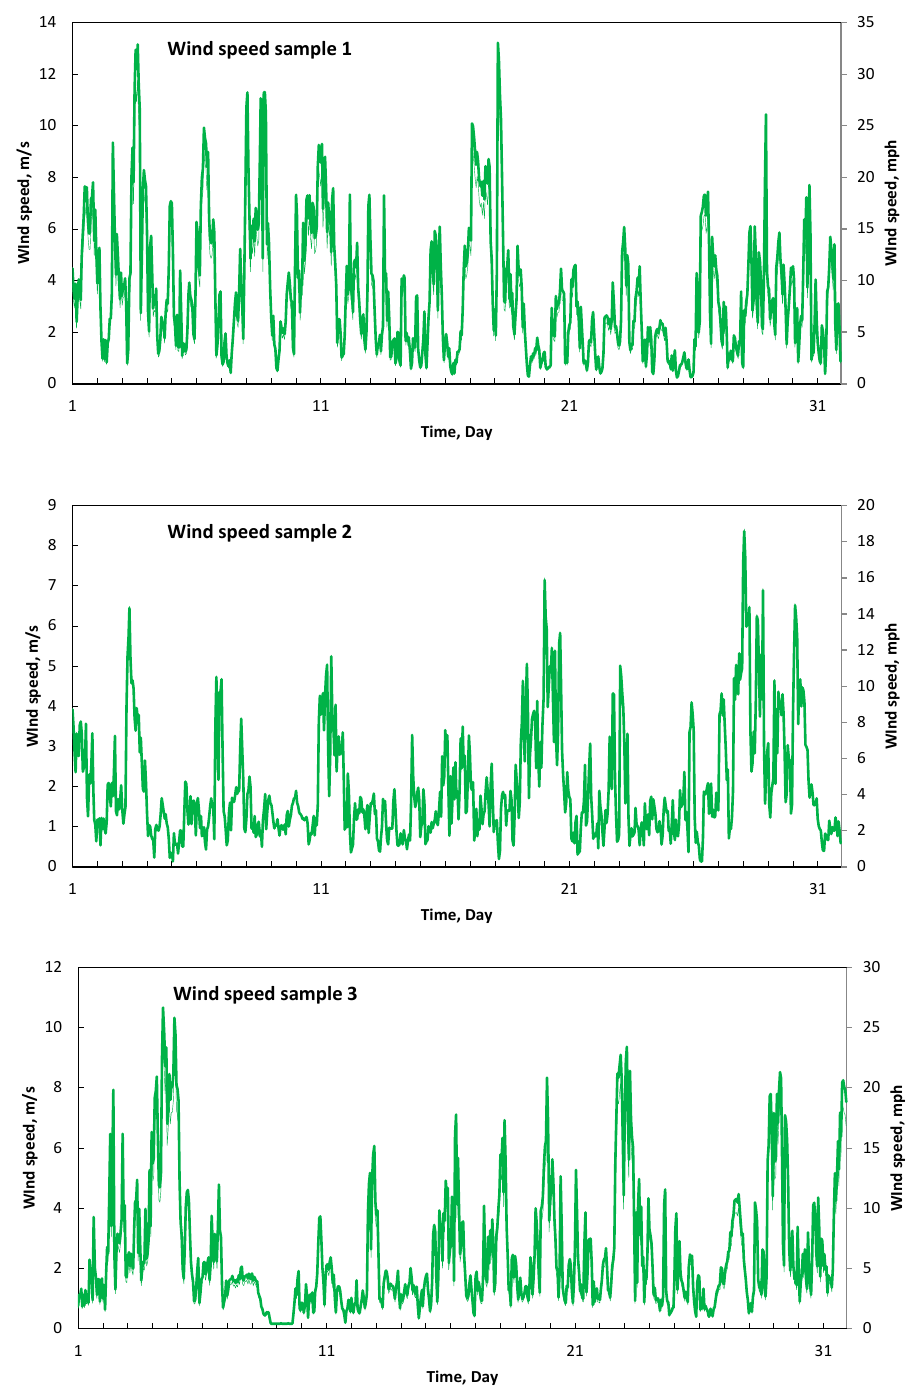
Figure 2. Time series plots of three wind speed samples. Table 1. Estimated parameters and performance measures for the first wind speed data sample.